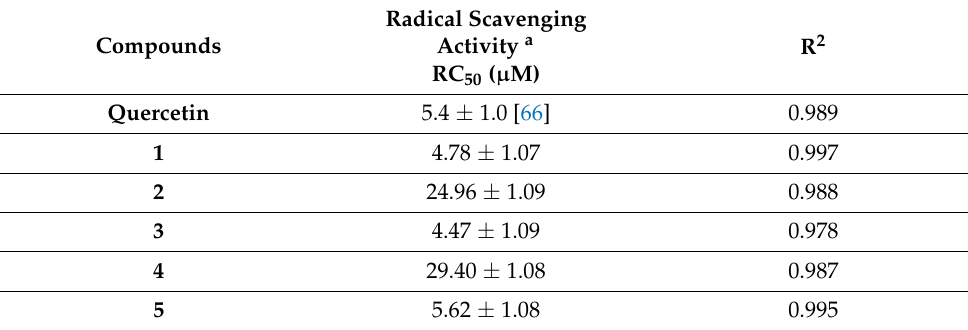
Table 2. Antioxidant activity based on DPPH radical scavenging